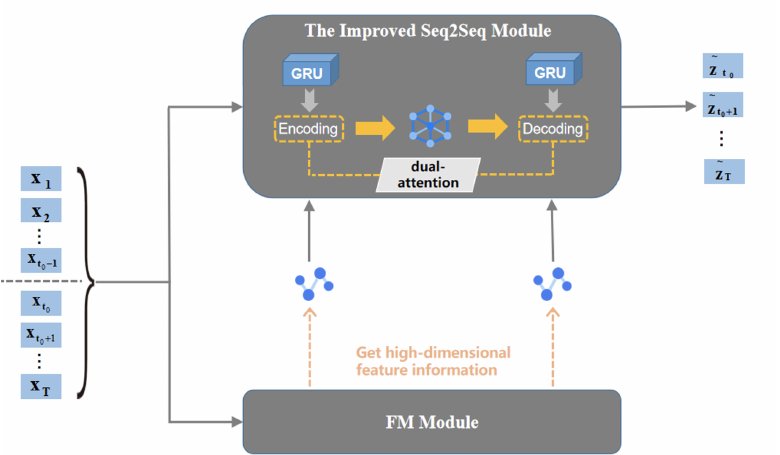
Figure 1. FM-GRU model